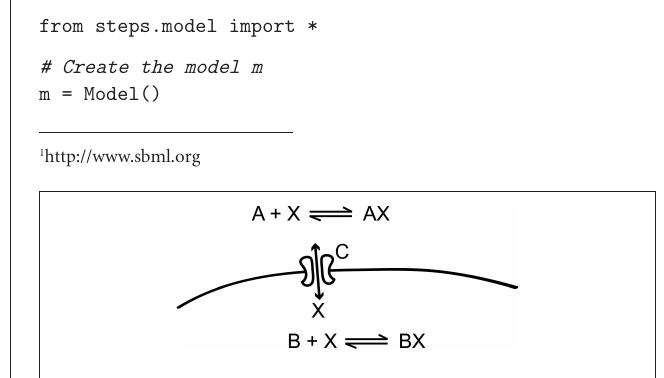
FIGURE 2 | This simple model, which is inspired by calcium dynamics, will be used to explain the STEPS implementation. It consists of two distinct chemical environments separated by a membrane. A substance X can be bound to buffer molecules of type A and B or it can be transported through a membrane channel C from one volume to the